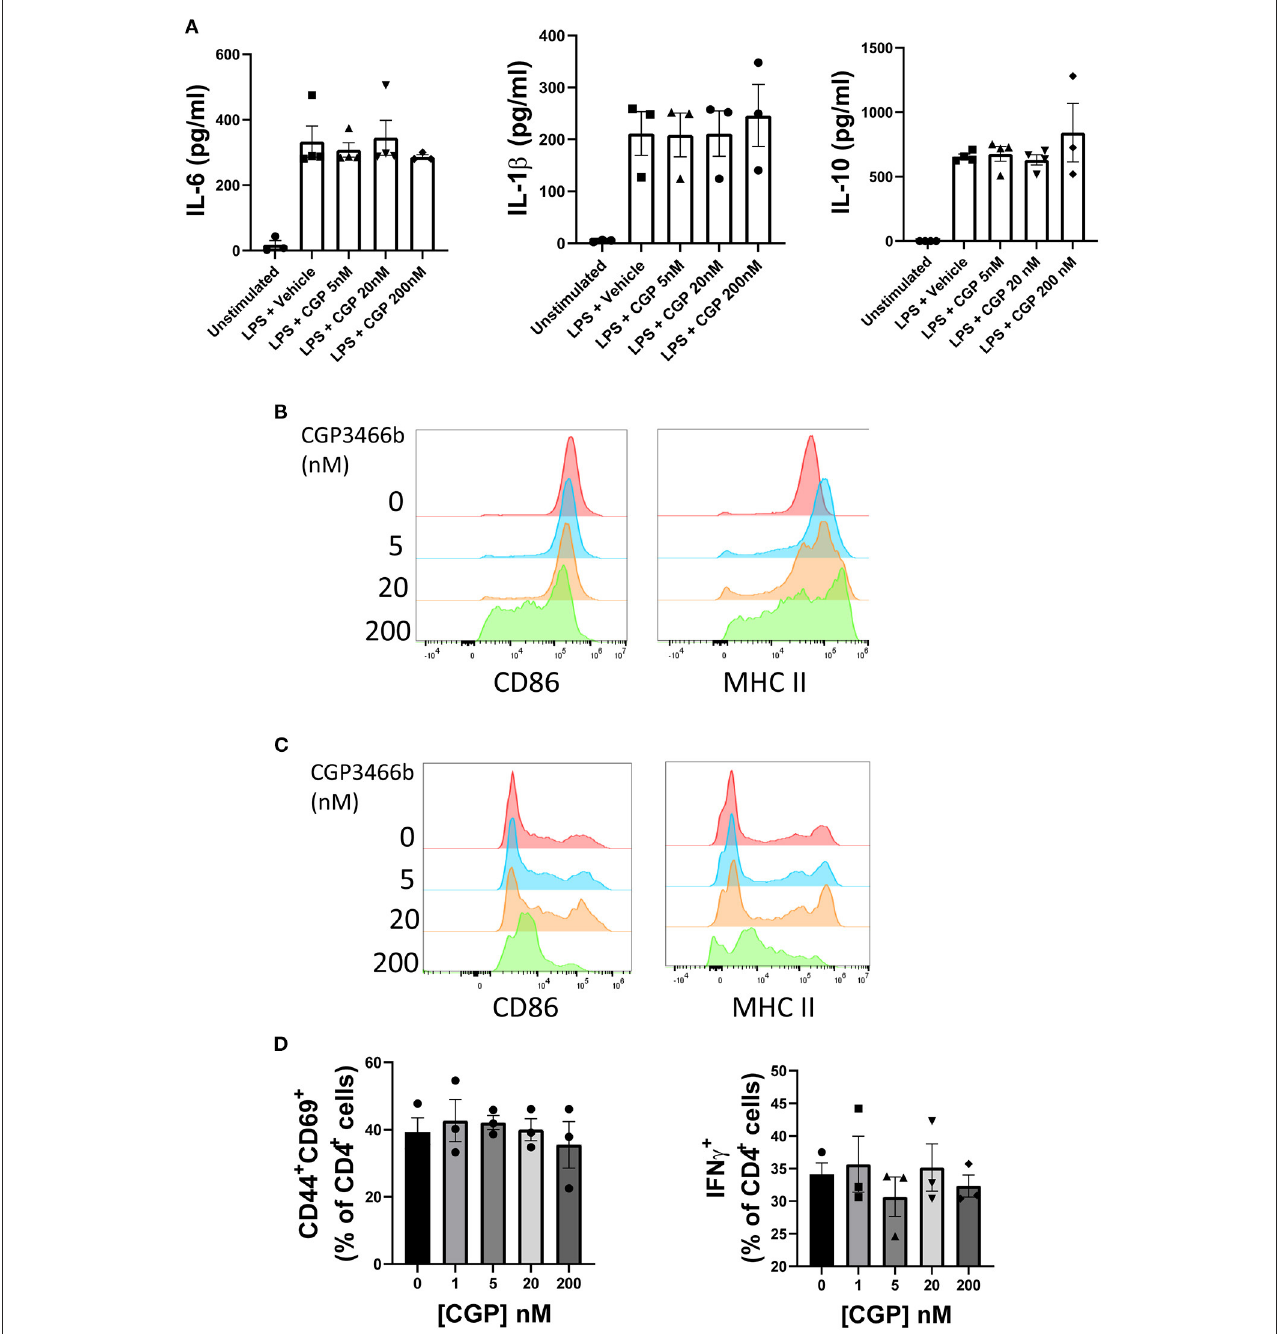
FIGURE3 CGP3466b has minimal direct effects on myeloid and lymphoid cells in vitro . (A) Bone marrow derived macrophages (BMMs) were treated with LPS (100ng/mL) plus vehicle or the indicated concentrations of CGP3466b for 24h. Cytokine concentrations in media were determined by ELISA. Data represent mean ± SEM of n = 3 or n = 4 independent experiments performed in triplicate. (B) BMMs and (C) Bone marrow derived dendritic cells (BMDCs) were treated with LPS (100ng/mL) plus vehicle or the indicated concentrations of CGP3466b, and expression of activation markers was measured by flow cytometry. Data are a representative example of n = 3 independent experiments. (D) CD4 + lymphocytes were stimulated with anti-CD3/CD28 antibodies (3 ug/mL) in the presence of vehicle or the indicated concentrations of CGP3466b. Percentage of CD4 + lymphocytes expressing the given activation markers was measured by flow cytometry. Data represent mean ± SEM of three biological